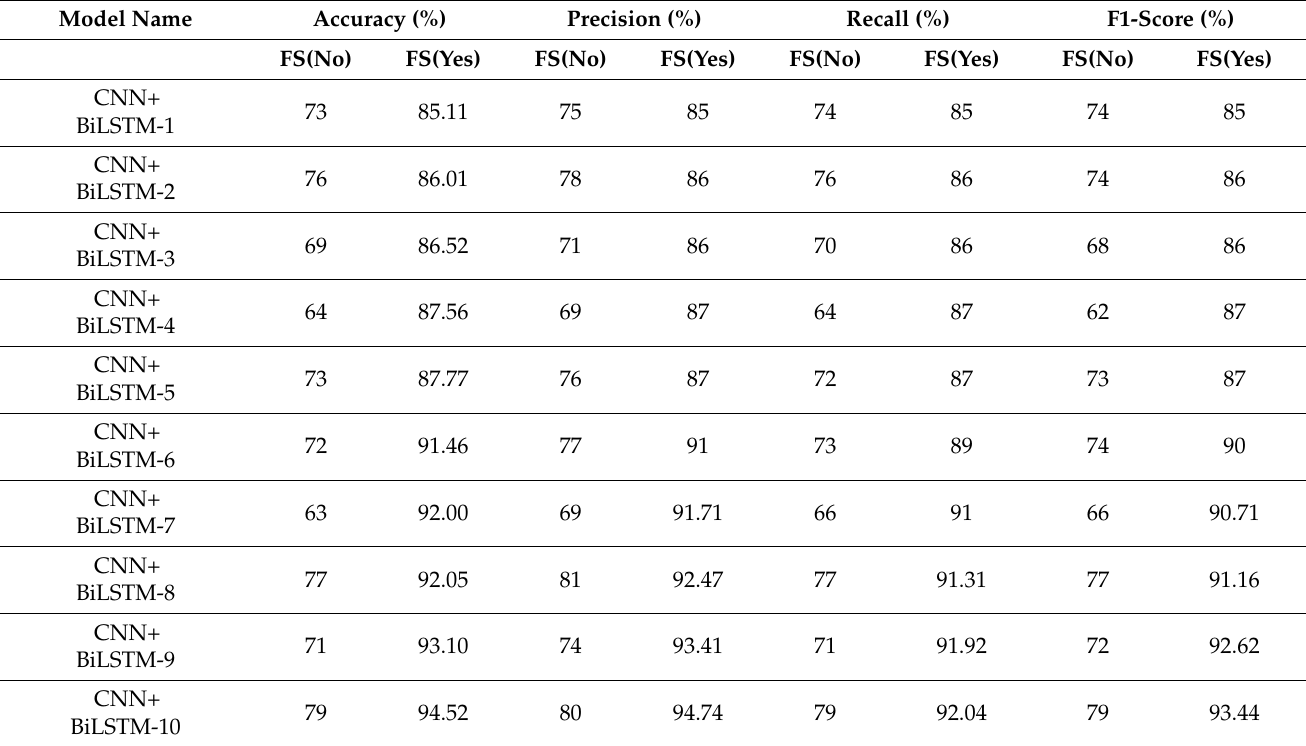
Table 7. Evaluation of the performance of CNN-BiLSTM models with and without feature selection [FS(no) = without selection of features, FS(yes) indicates with selection of features].